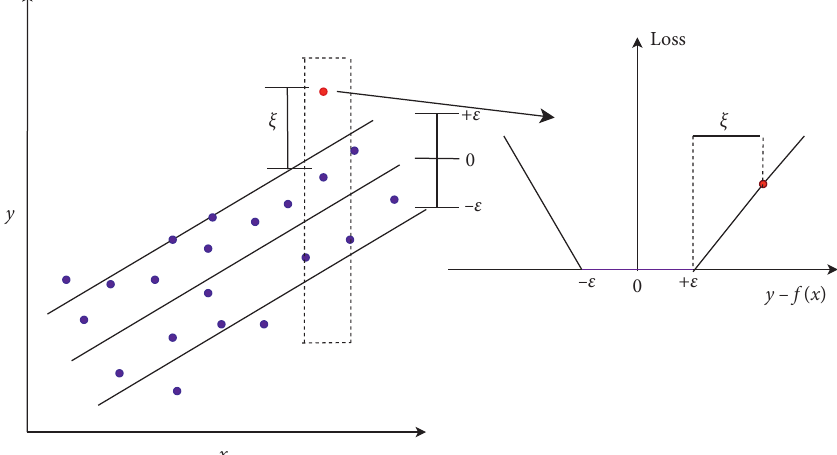
Figure 3: SVM regression with ε -insensitive loss